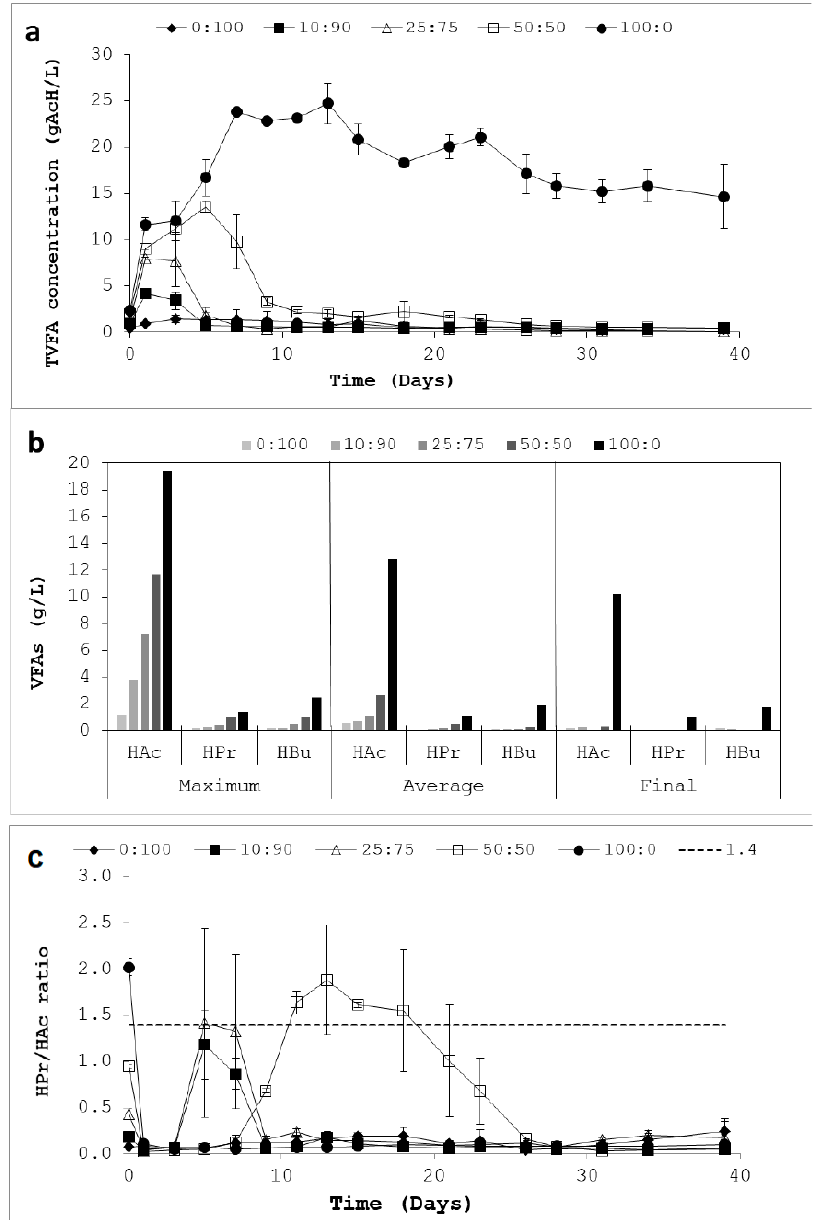
Figure 3. Evolution of total volatile fatty acidity (TVFA) concentration ( a ), the individual volatile fatty acids (VFAs) ( b ), and the ratio propionic (HPr)/ Acetic (HAc) acid ( c ) in all the ESBP:PM ratios.